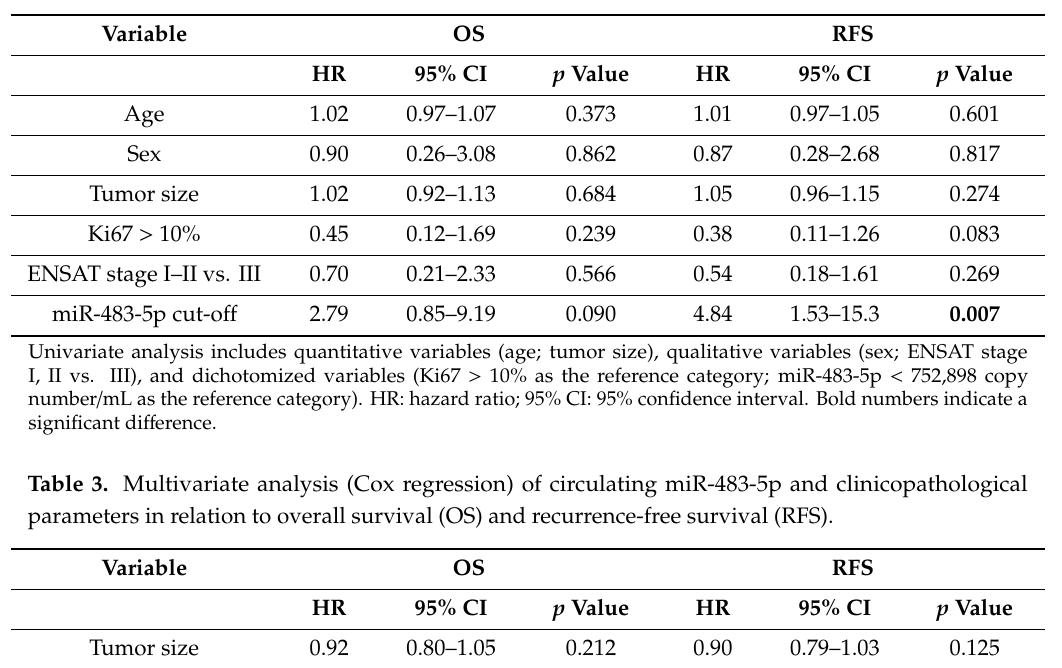
Table 2. Univariate analysis (Cox regression) of circulating miR-483-5p and clinicopathological parameters in relation to overall survival (OS) and recurrence-free survival (RFS).